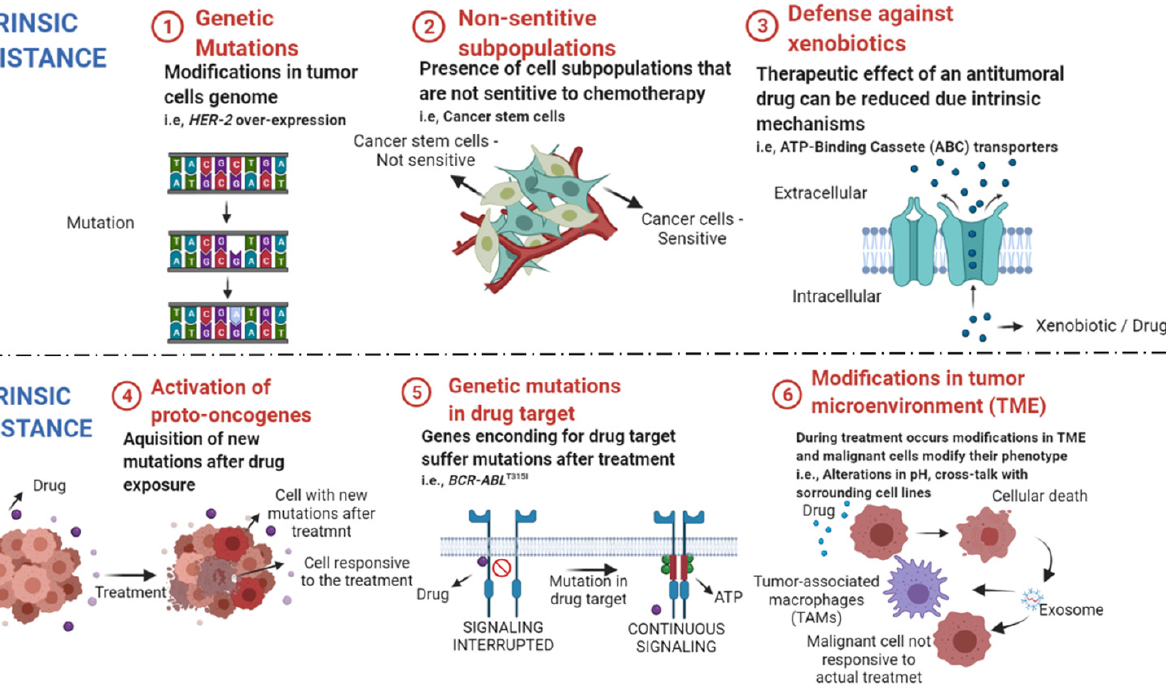
Figure 1. Intrinsic and extrinsic mechanisms of drug resistance in cancer. ① Genetic mutations can lead to alterations in the expression of genes related to cellular resistance and surveillance. ② Heterogenous tumors have subpopulations that may not respond to the available cytotoxic drugs, leading to cancer remission after treatment. ③ Some cellular transporters protect our cells from environmental toxins, as anticancer drugs, and reduce the concentration of their intracellular levels. ④ After treatment, new oncogenes can be activated, leading to enhanced proliferation rate of not responsive cells. ⑤ Mutations in genes that encode drug targets reduce drug efficacy in mutated cell lines. ⑥ Treatment can alter the tumor microenvironment (TME) and lead to cross-talk between sensitive cells and the surrounding cells. The exchange of resistance elements with tumor-associated macrophages (TAMs) and other tumoral cell lines lead to enhanced cell resistance to chemotherapy. Created with BioRender.com, accessed date: 20 August 2021.